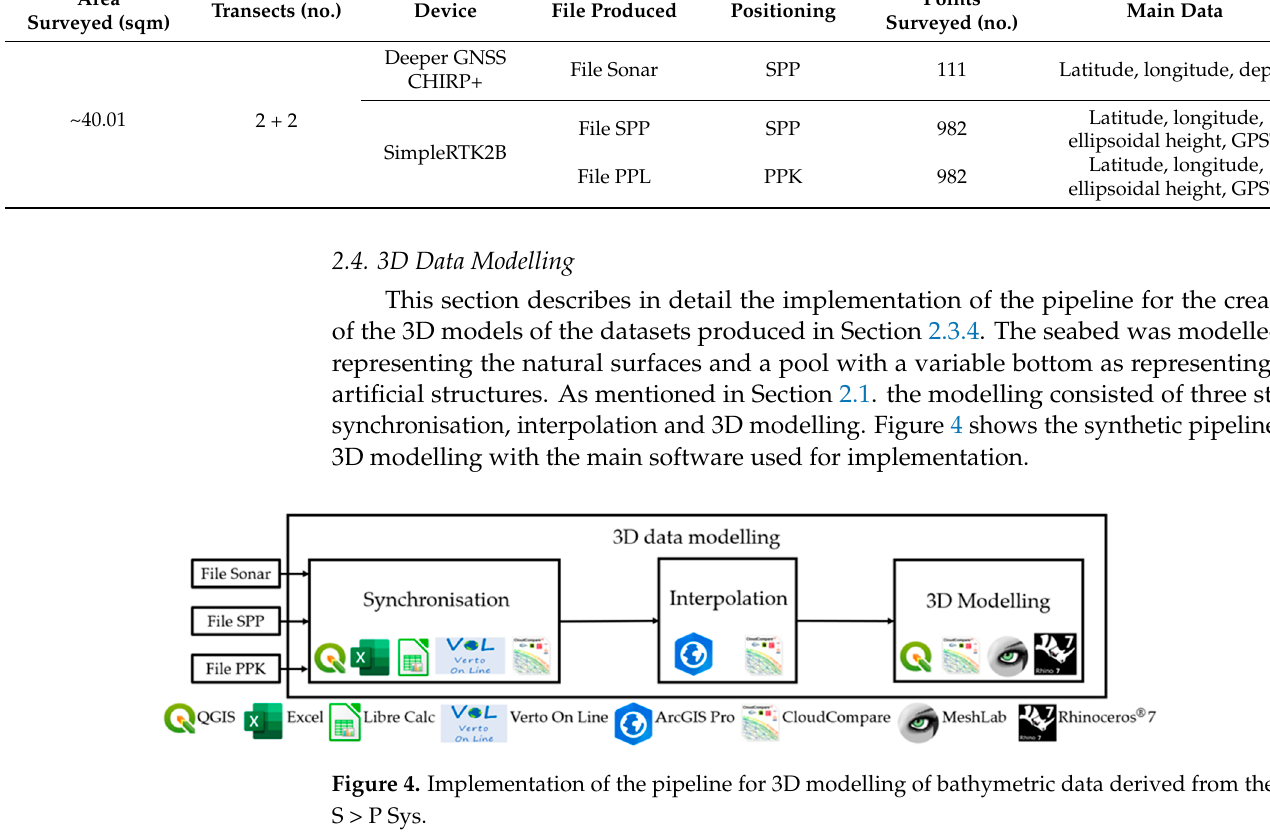
Table 8. Datasets for 3D modelling of the pool (artificial structure).